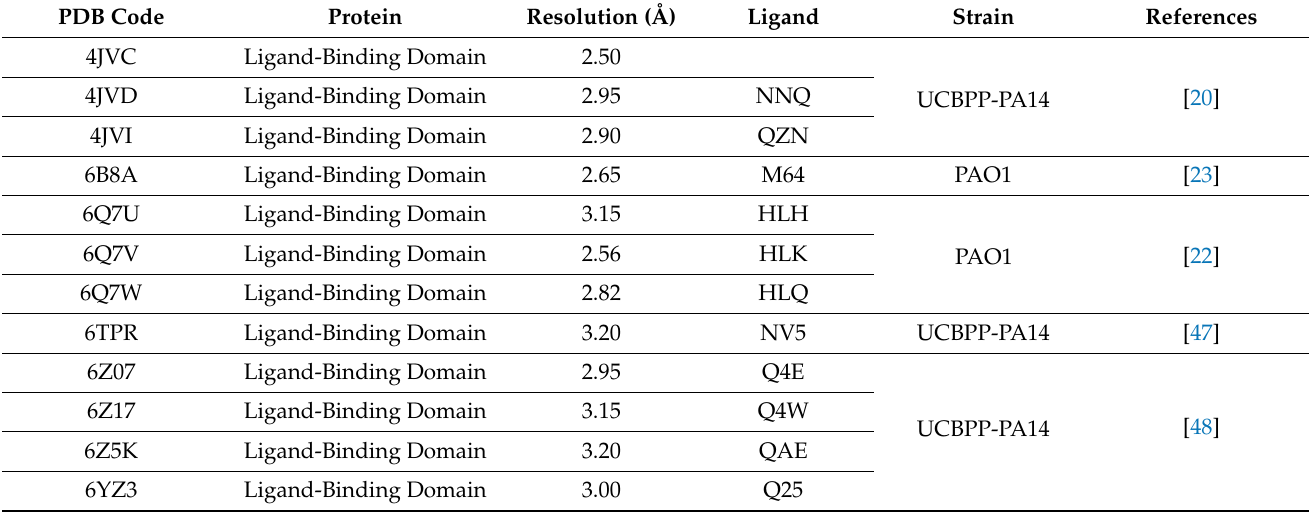
Table 5. Available X-ray structures of MvfR on the PDB and